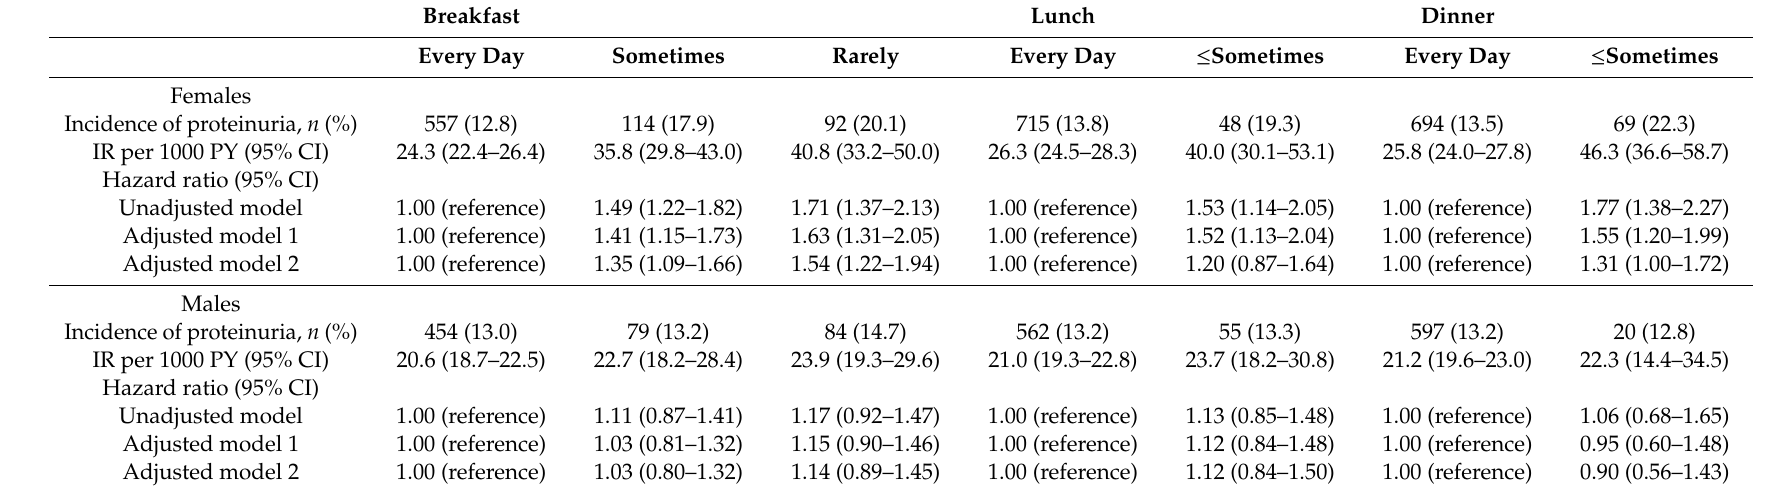
Table 3. Meal frequency and the incidence of proteinuria in 5439 females and 4674